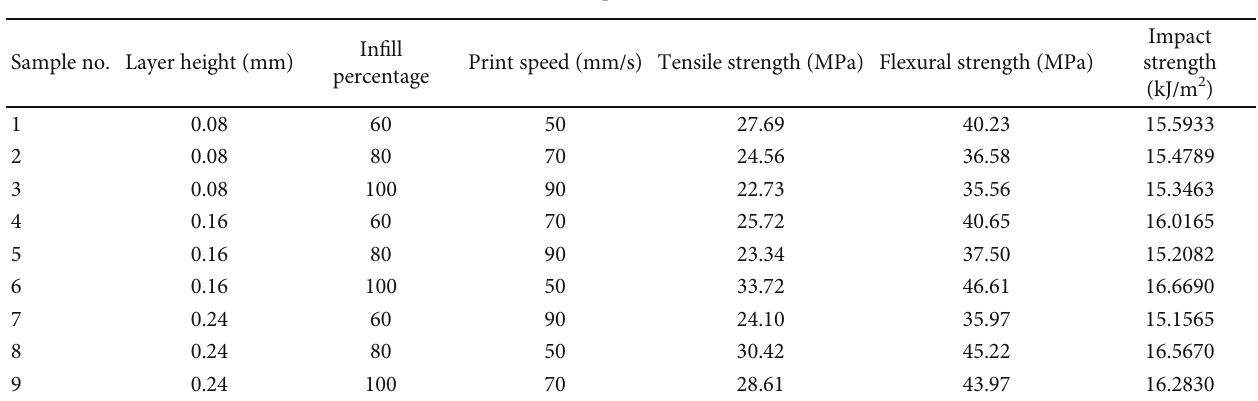
Table 2: Experimental results.